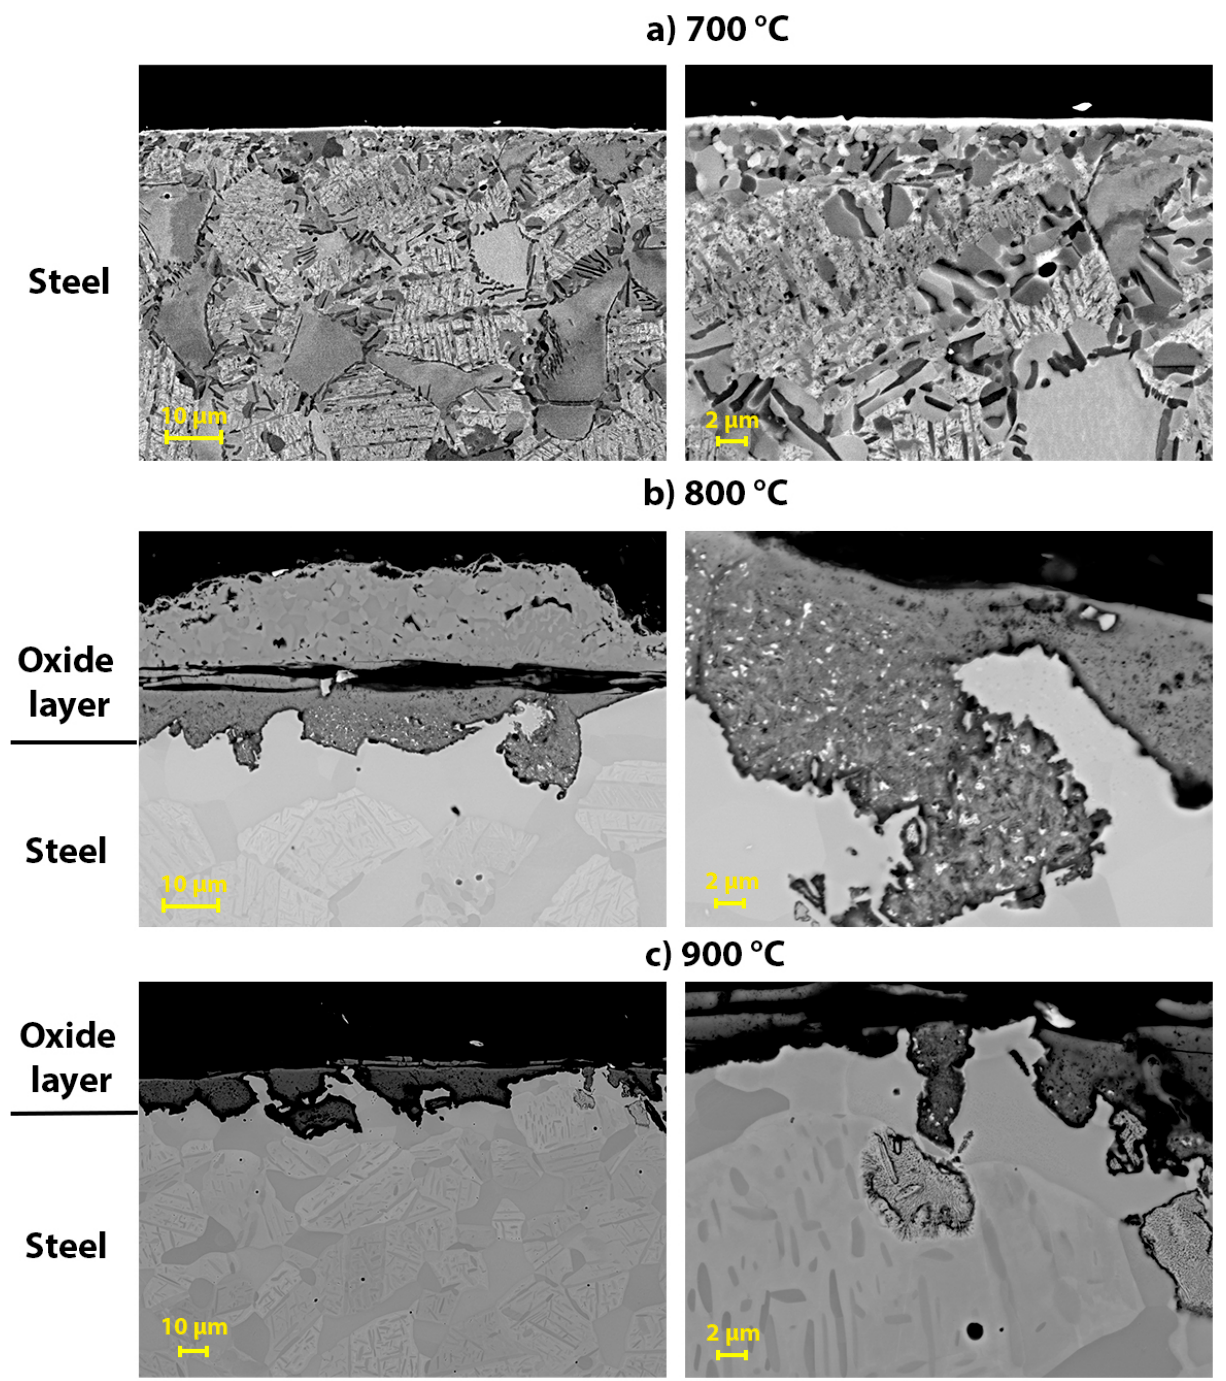
Figure 3. Oxide layers formed after high-temperature oxidation at ( a ) 700, ( b ) 800 and ( c ) 900 °C.